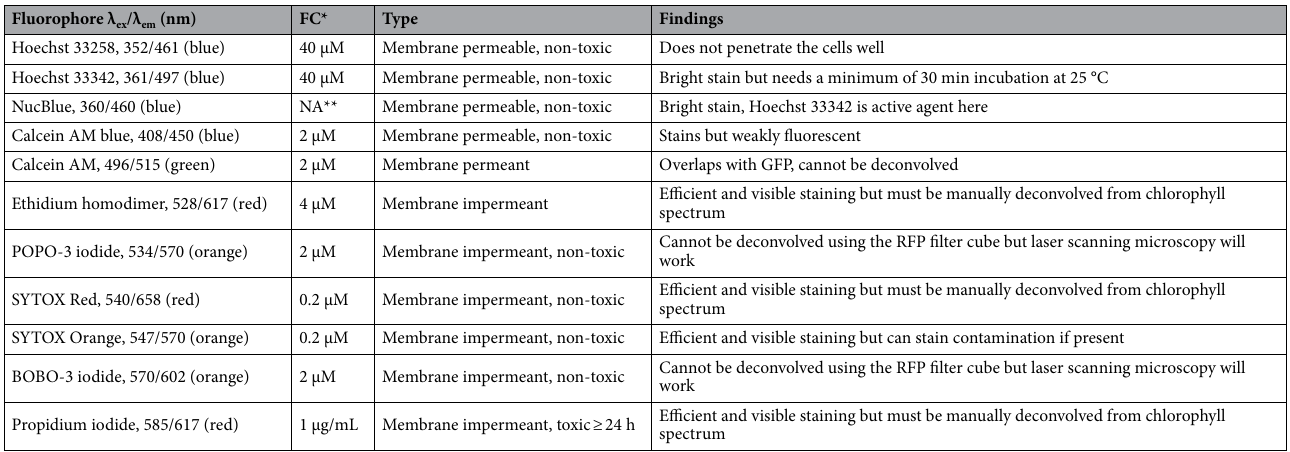
Table 1. Fluorophores tested on coral cells and conclusions. * FC final concentration in cell suspension. **Not specified by